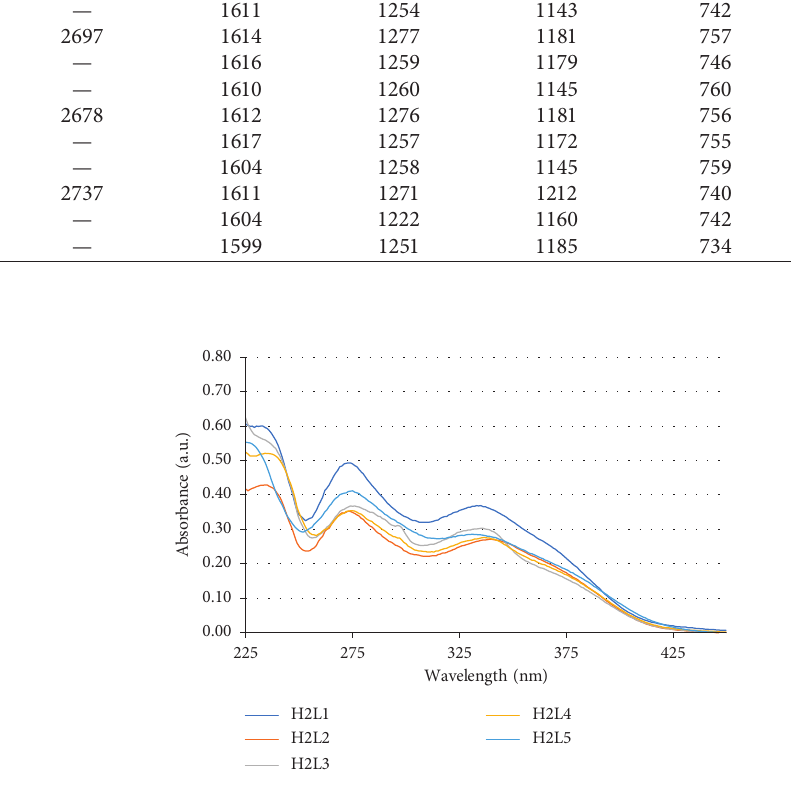
Figure 1: UV-Vis absorption spectra of unsymmetrical tetradentate Schiff base